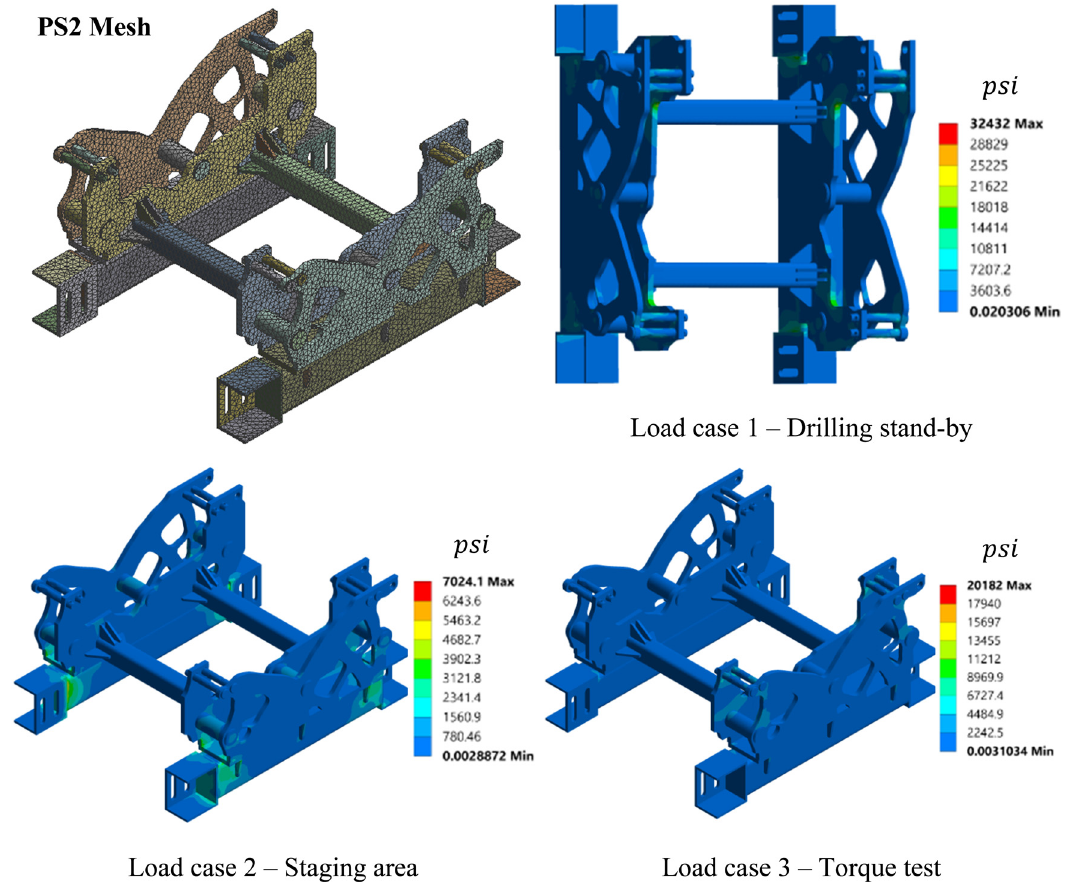
Figure 17: Structural response of topology - optimized result from PS2 against three load